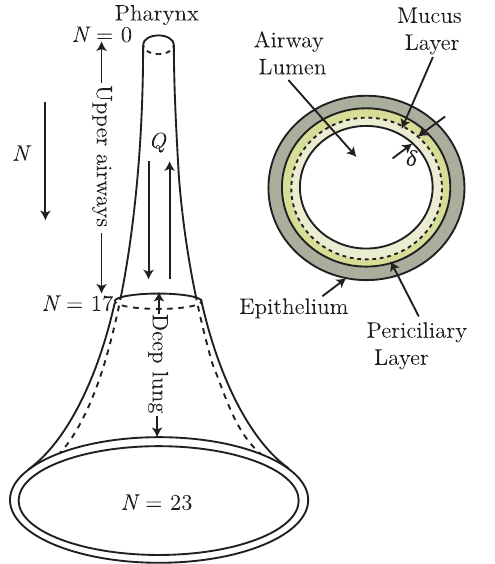
Fig 1. Schematic illustration of the one-dimensional trumpet model that is used in the present analysis to approximate the dichotomous network structure of a human lungs. A cross-sectional view of a single airway branch is also shown to illustrate the arrangement of the airway lumen and the epithelial lining with respect to the intermediate mucus layer and the periciliary layer.